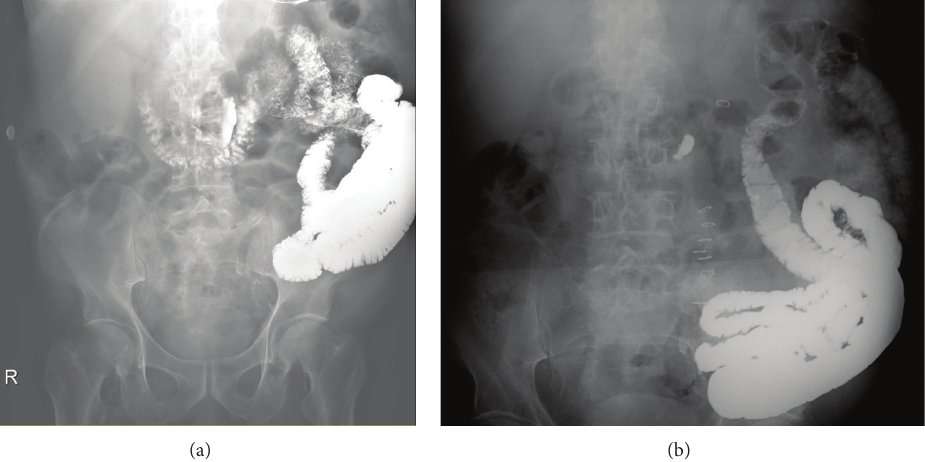
Figure 3: (a) Abdominal X-ray taken three days before the patient’s small bowel resection. (b) Abdominal X-ray taken nine days after the patient’s small bowel resection. Note how the contrast has not progressed and remains in the distal jejunum and